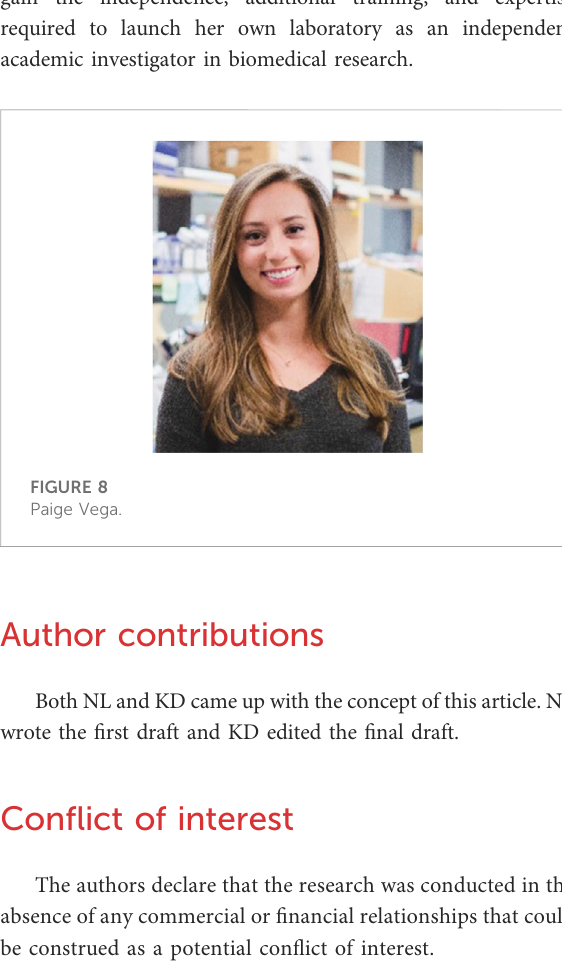
FIGURE 6 Dr. Ivana Sequeira.